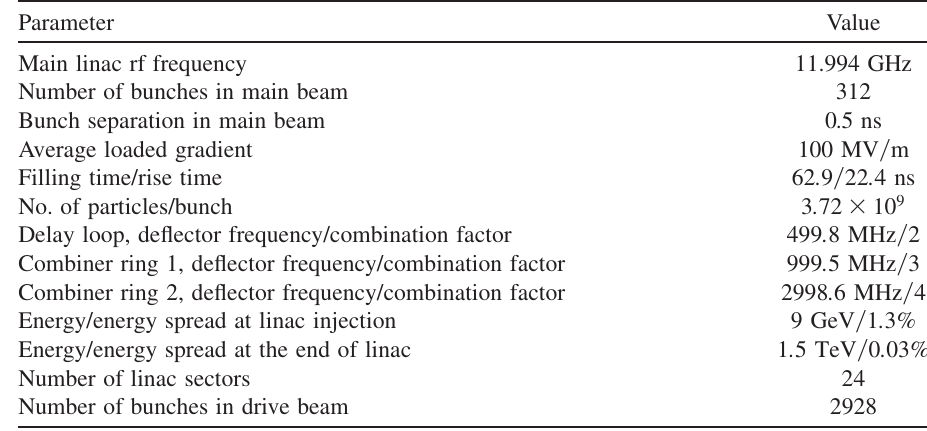
TABLE I. Selected nominal CLIC parameters relevant for the beam-loading compensation.